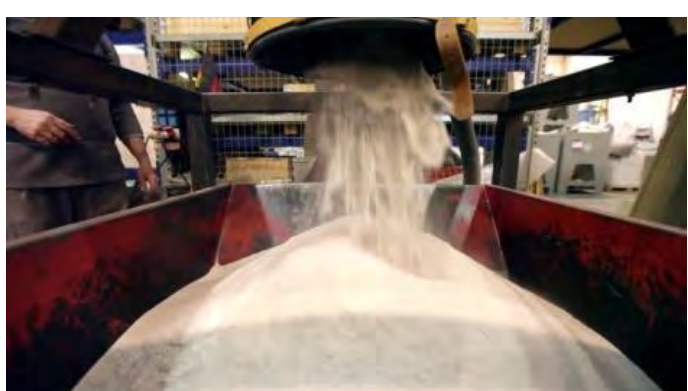
Figure 13. TheExcessive sands while printing process